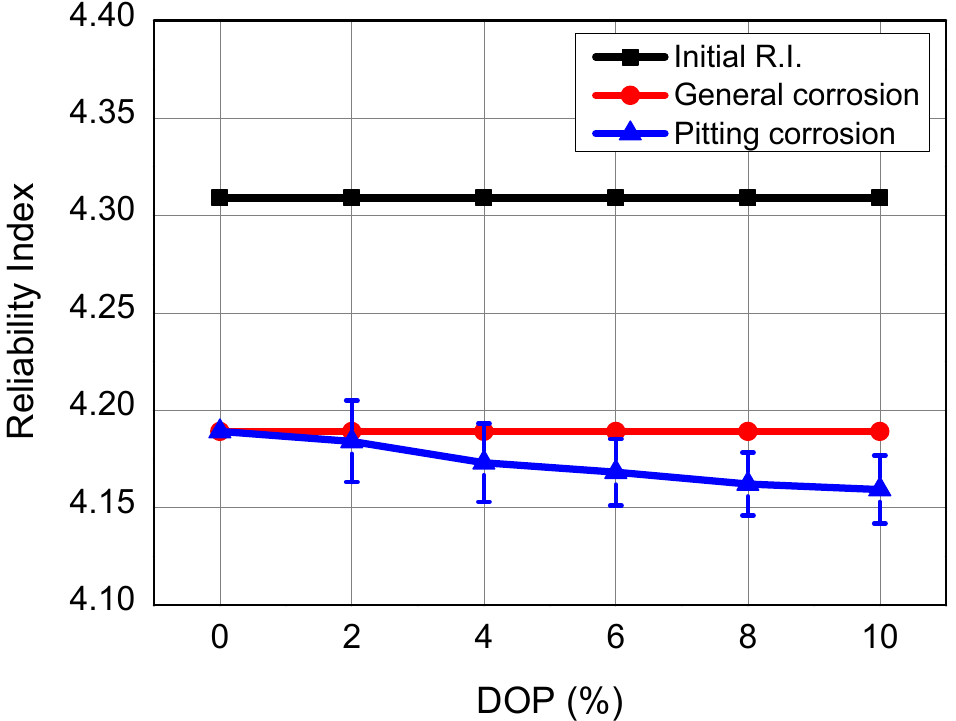
Figure 9. Results of structural reliability analysis with DOP change.